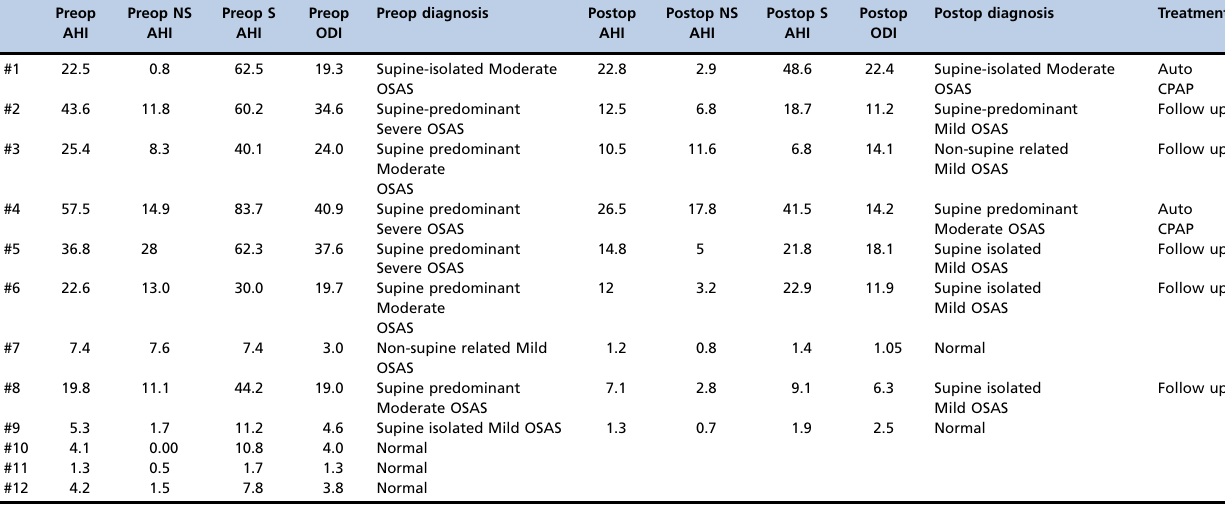
Table 1 - Preoperative and postoperative PSG results and the preferred types of treatment.